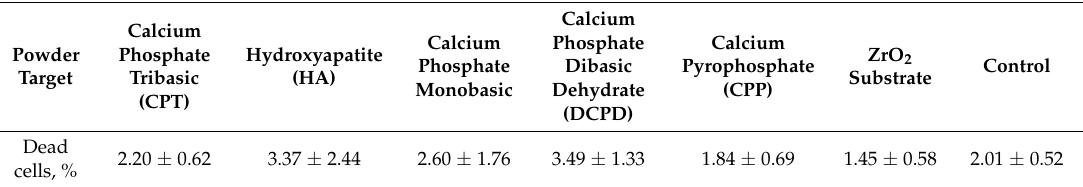
Table 6. The percentage of dead adipose-derived MSCs after cultivation with Ca-P coatings prepared from different targets by RF-magnetron